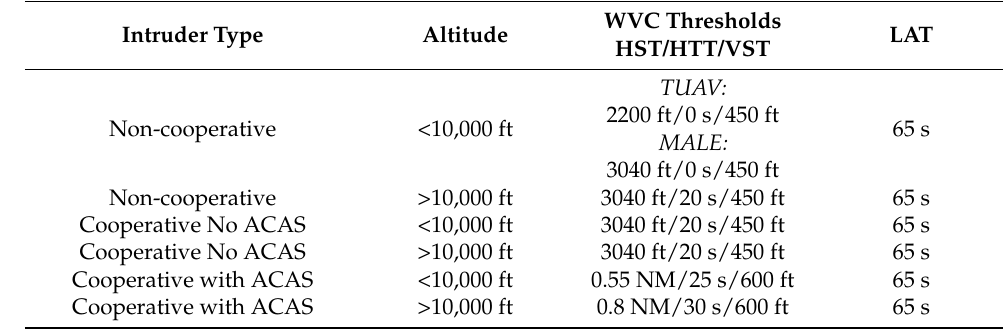
Table 2. TUAV/RUAV and MALE WCV quantification and alerting